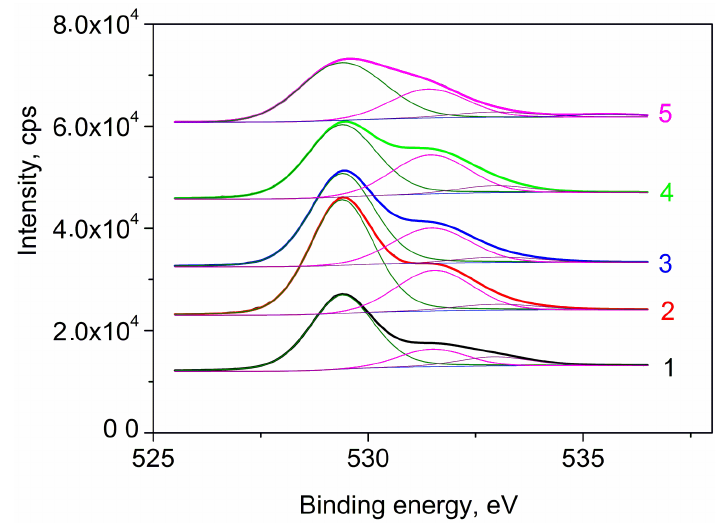
Figure 5. O1s X-ray photoelectron spectra of the catalysts reduced at 800 °C. 1—Ni/CeMg-C-S-O; 2—Ni/CeMg-A-S-O; 3—Ni/CeMg-A-S-V-500; 4—Ni-Pd/CeMg-A-S-V, 5—Ni/CeMg-A-P-O. Table 4. XPS results of catalysts.